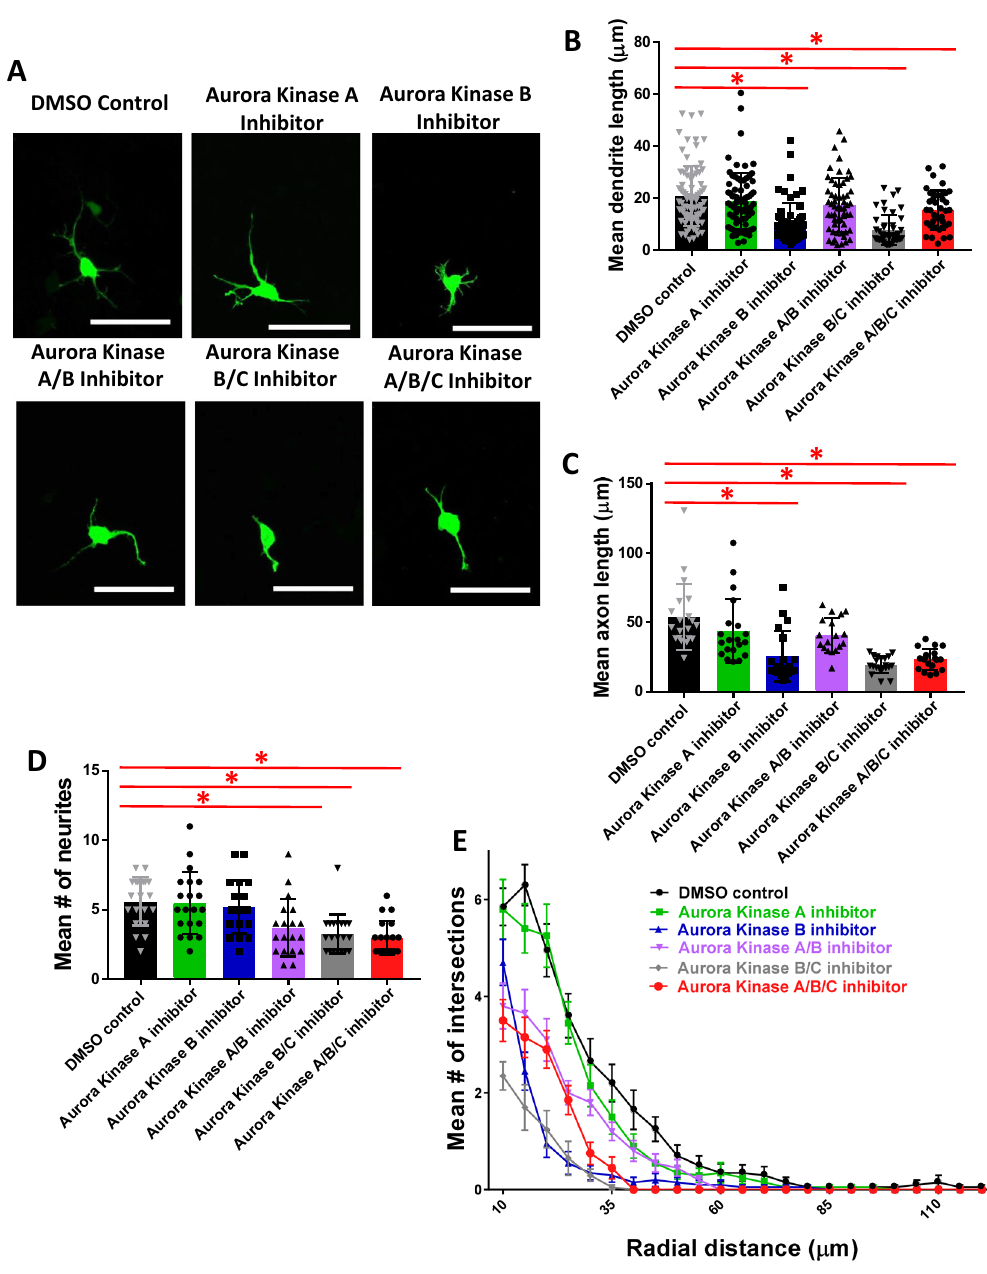
Figure 2. Inhibition of Aurora Kinases A, B, A/B, B/C, and A/B/C in primary cortical neurons suggests roles for Aurora B and C in neurite initiation/elongation and arborization. ( A ) Primary cortical mouse neurons transfected with YFP and treated with Aurora kinase inhibitors, scale bars 50 µm. ( B ) One-way ANOVA showed significant difference in length of neurites likely to become dendrites [F(5,354) = 16.941, p < 0.0005]. There was a significant decrease in neurons treated with Aurora B inhibitor (10.6 ± 0.95, n = 64, p < 0.0005), Aurora B/C inhibitor (7.7 ± 0.86, n = 46, p < 0.0005), or Aurora A/B/C inhibitor (15.5 ± 1.21, n = 39, p = 0.49) compared to DMSO control (21.0 ± 1.29, n = 80). There was no significant difference between neurons treated with Aurora A inhibitor (18.9 ± 1.26, n = 74, p = 1.000) or Aurora A/B inhibitor (17.4 ± 1.38, n = 57, p = 0.437) compared to DMSO control. ( C ) One-way ANOVA showed significant difference in length of neurites likely to become axons [F(5,111) = 12.946, p < 0.0005]. There was a significant decrease in neurons treated Aurora B inhibitor (25.7 ± 4.08, n = 20, p < 0.0005), Aurora B/C inhibitor (19.6 ± 1.36, n = 20, p < 0.0005), or Aurora A/B/C inhibitor (23.4 ± 1.73, n = 19, p < 0.0005) compared to DMSO treated control (54.1 ± 5.33, n = 20). There was no significant difference between neurons treated with Aurora A inhibitor (43.8 ± 5.13, n = 20, p = 0.860) or Aurora A/B inhibitor (40.7 ± 2.98, n = 18, p = 0.247) compared to DMSO control. ( D ) One-way ANOVA showed significant difference in mean number of neurites [F(5,113) = 8.941, p < 0.0005]. There was a significant decrease in neurons treated with Aurora A/B inhibitor (3.68 ± 0.47, n = 19, p = 0.017), Aurora B/C inhibitor (3.25 ± 0.32, p = 0.001), and Aurora A/B/C inhibitor (2.95 ± 0.28, p < 0.0005) compared to the DMSO treated controls (5.60 ± 0.39). There was no significant difference between neurons treated with Aurora A inhibitor (5.50 ± 0.50, p = 1.000) or Aurora B inhibitor (5.20 ± 0.43, p = 1.000) and DMSO control. For all groups, n = 20 unless otherwise noted. ( E ) Sholl analysis shows dramatic decrease in branching after treatment with Aurora Kinase B, A/B, B/C, and A/B/C inhibitors and a mild decrease in branching after Aurora Kinase A inhibitor